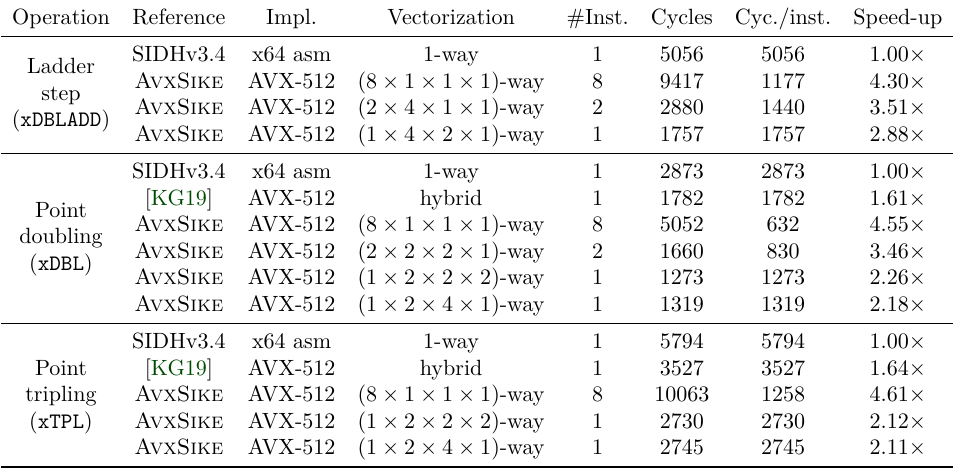
Table 3: Experimental results of point-operation implementations for SIKEp503 . Operation Reference Impl.